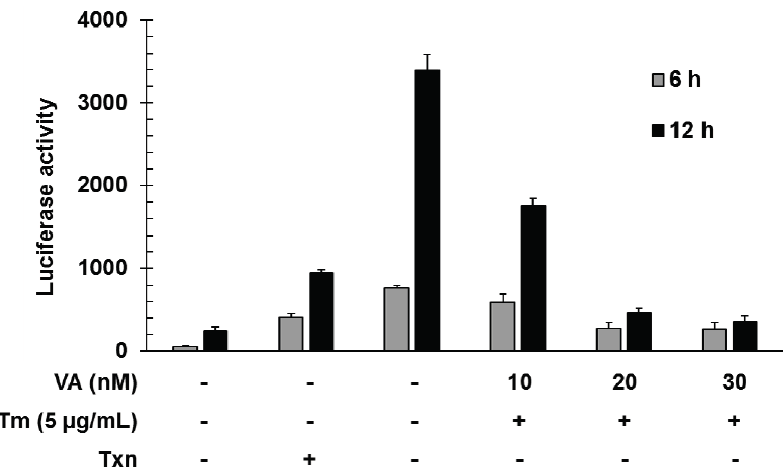
Figure 2. Inhibitory effects of GRP78 induced by verrucarin A in FaO rat liver cells. Cells in 24-well plates were transfected with 0.8 mg of GRP78-Luc for 5 h and then incubated in serum medium. After 24 h, each dose 10, 20, and 30 nM verrucarin A pre-treated for 1 h, and then 5 μ g·mL − 1 tunicamycin (Tm) treated for 6 and 12 h. Subsequently, the cells were